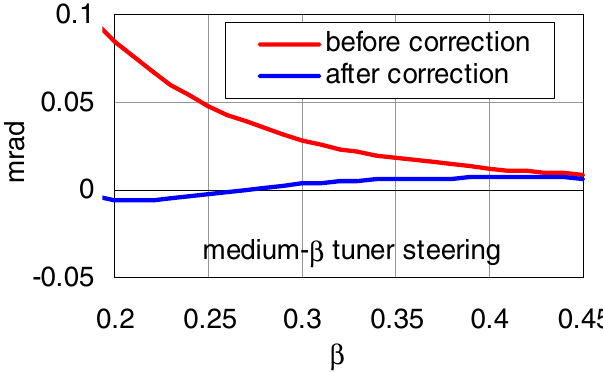
FIG. 6. (Color) Tuner horizontal beam steering compensation in the medium- (cid:1) cavity. Steering (mrad) vs (cid:1) . Blue line: on axis; red line: 0.4 mm off